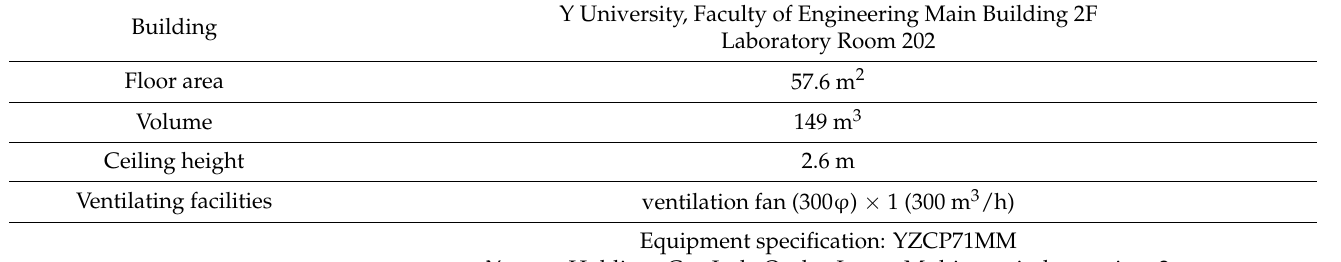
Table 1. Outline of the study room.